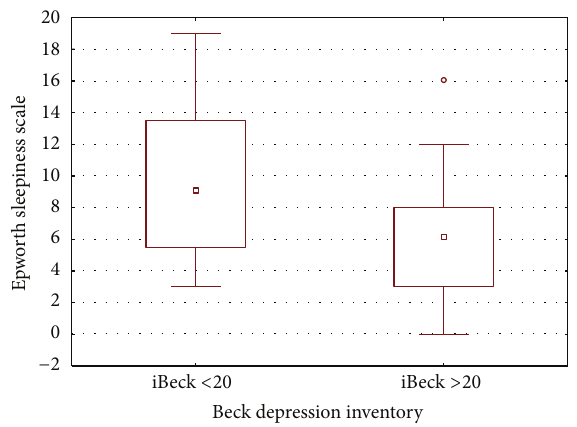
Figure 1: Association of daytime sleepiness, by the Epworth sleepiness scale, and depressive symptoms, as the Beck depression